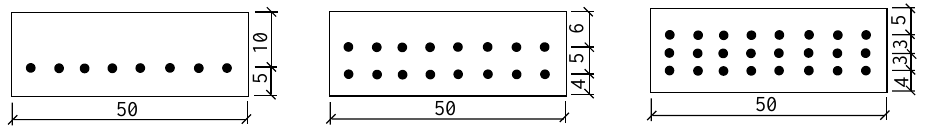
Figure 3. Cross section of the specimens with different number of textile layers (unit: mm).